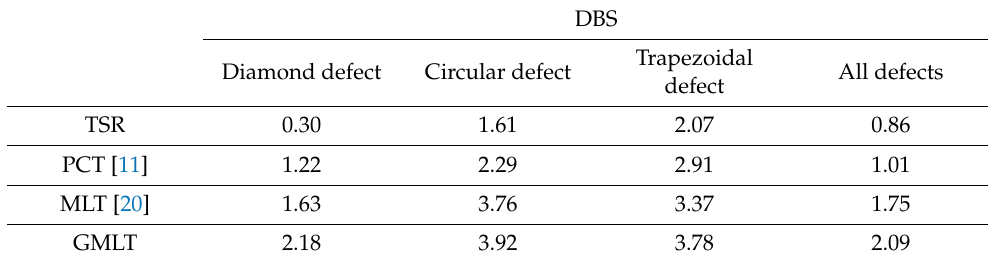
Table 2. Comparison of DBS values of various